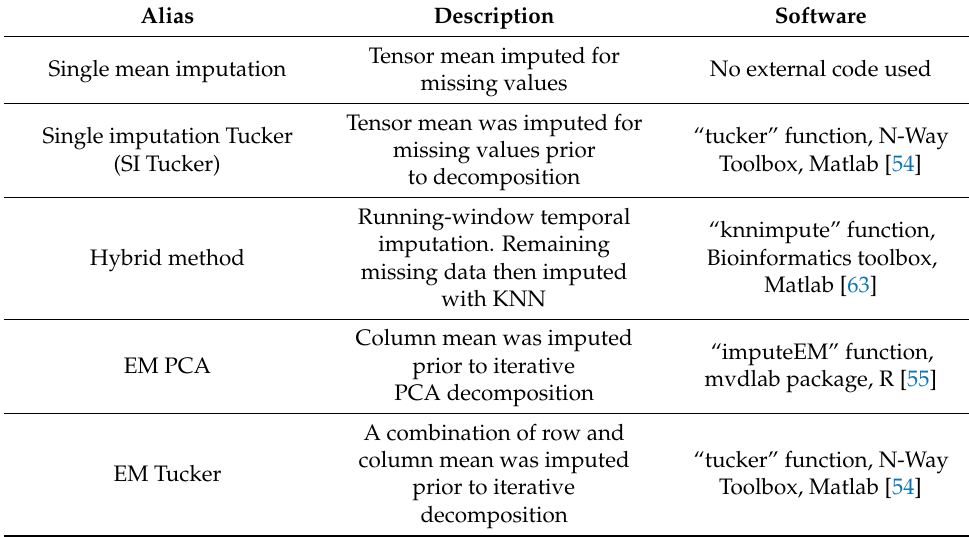
Table 2. An overview of all imputation methods applied in this